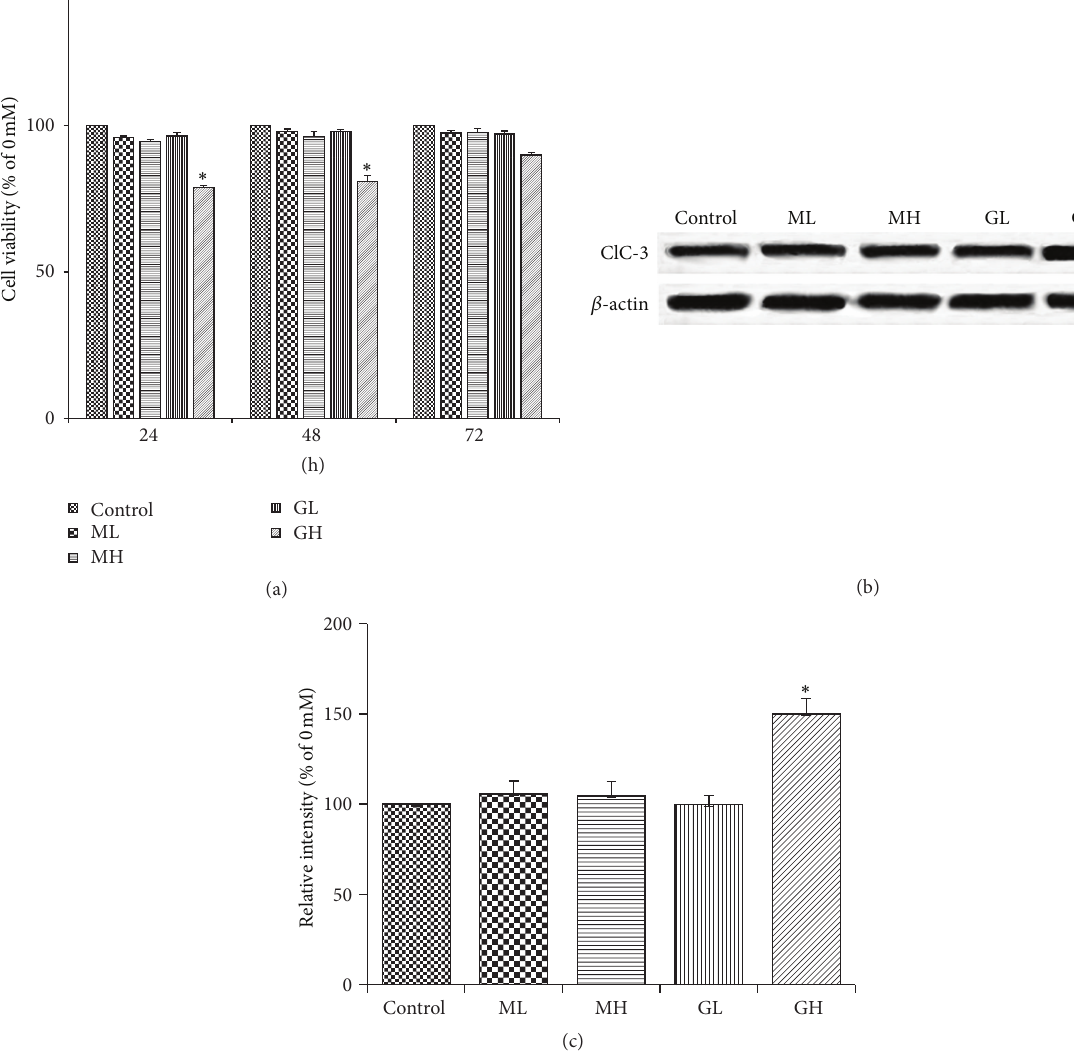
Figure 5: Osmotic control experiment: MTT cell viability assay, results of glucose and mannitol (osmotic control) groups obtained at 24 h, 48 h, and 72 h displayed in terms of the percentage of viable cells (% of 0mM) (a). Western blot analysis of HT22 cell lysates from control, mannitol, and glucose groups, at 24 h, for ClC-3 protein expression (b) and quantification of their respective intensity levels (ratio of ClC-3 band to standard 𝛽 -actin band) (c) showed a significant increase in the expression level of ClC-3 in high glucose group ( 𝑃 < 0.05 ). Control: normal osmolarity (25mM) group, ML: mannitol low osmolarity (30mM) group, MH: mannitol high osmolarity (50 mM) group, GL: glucose low osmolarity (30mM) group, and GH: glucose high osmolarity (50 mM)